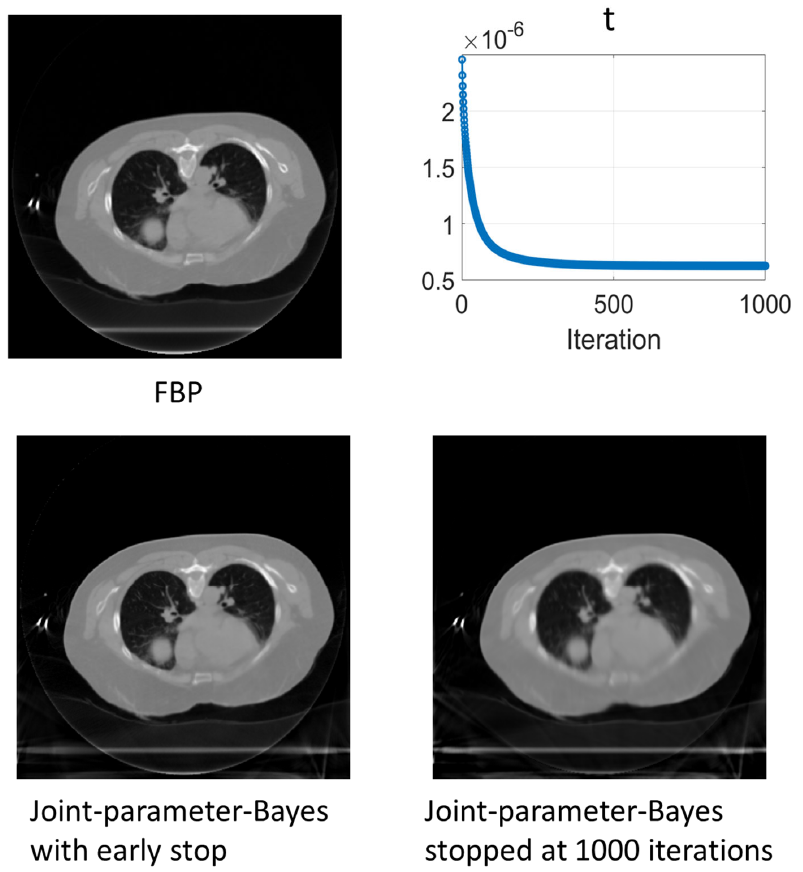
Figure 10. Comparison of reconstructed images between the conventional MAP and joint-parameter- Bayes. The CT image display window is [0, 0.035] mm − 1 .